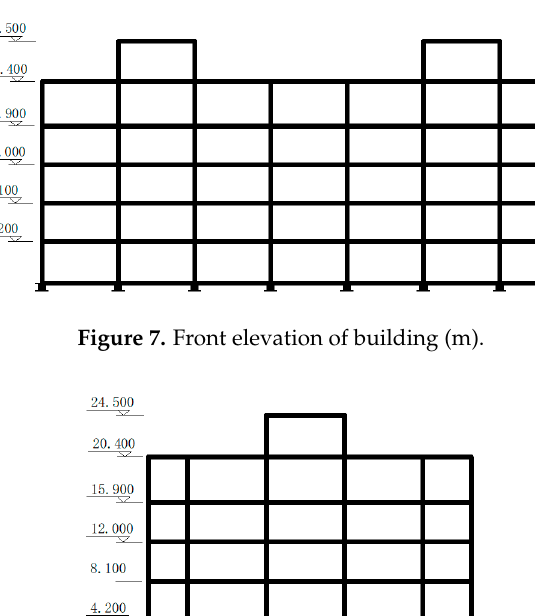
Figure 6. Arrangement of the beams and pillars (mm).